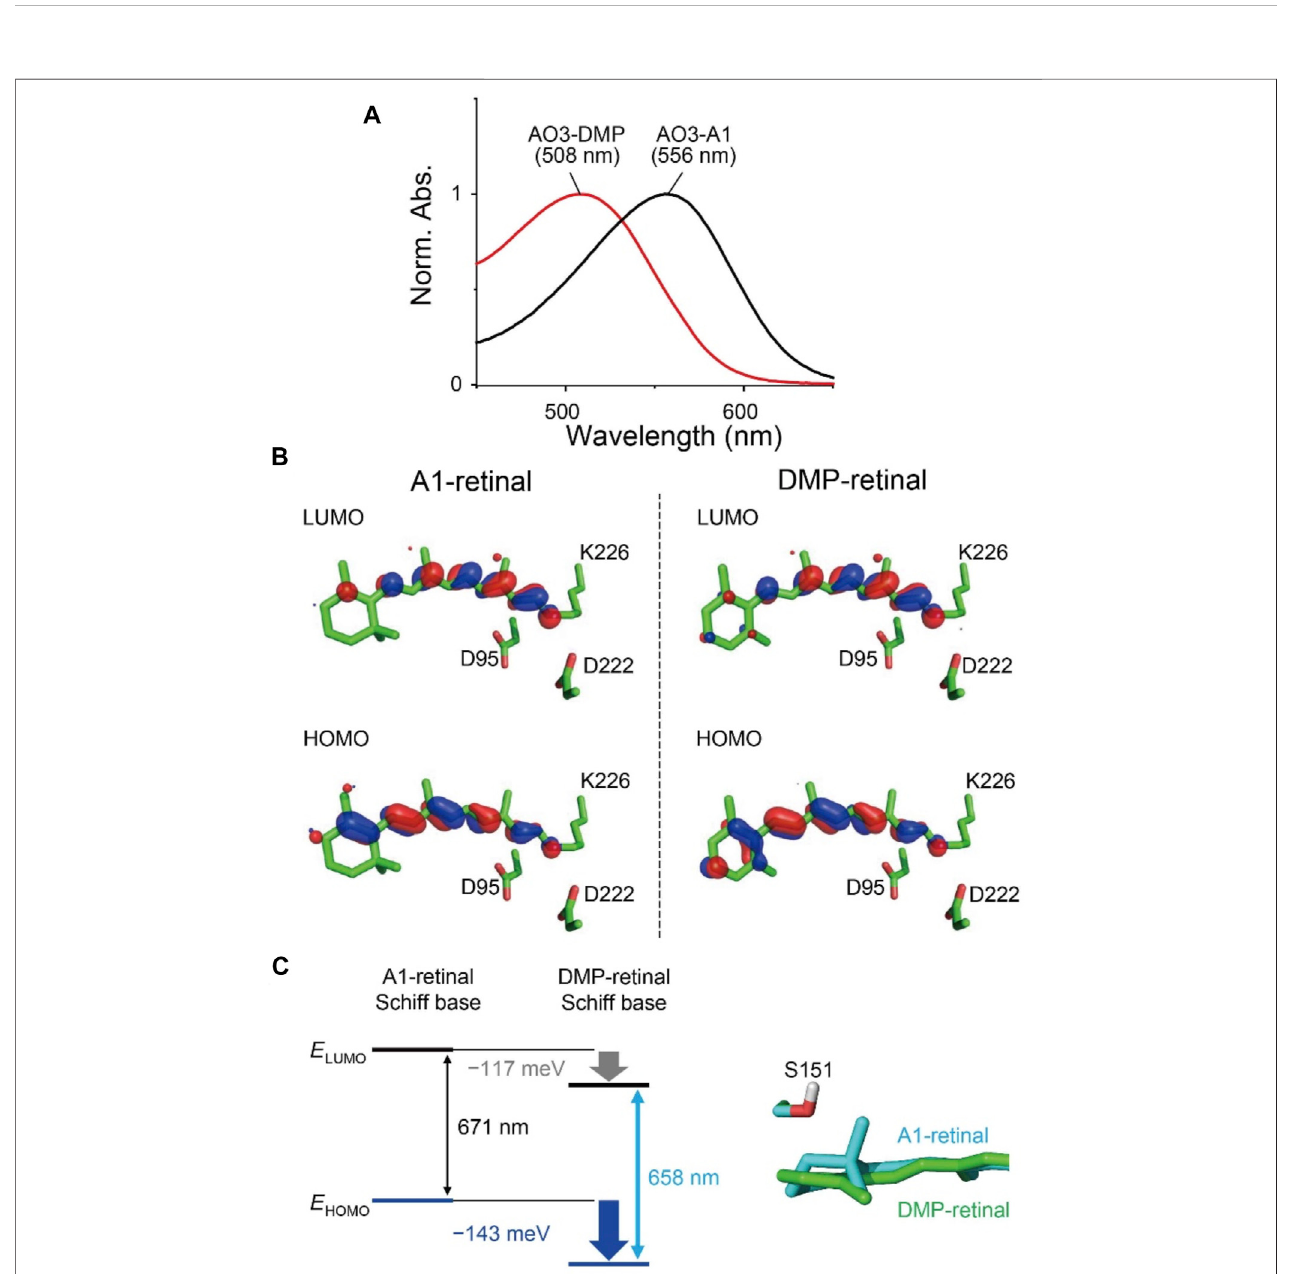
FIGURE 3 | Absorption properties of AO3 with A1-retinal and DMP-retinal. (A) Absorption spectra of puri fi ed AO3 with A1-retinal (AO3-A1, black line) and DMP- retinal(AO3-DMP,redline). (B) HOMOandLUMOforA1-retinal (left) andDMP-retinal (right) SchiffbasesintheAO3proteinenvironments. (C) DifferenceinHOMOand LUMOenergybetweenA1-retinalandDMP-retinalSchiffbasesintheabsenceoftheproteinenvironment(i.e.invacuum) (left) anddifferenceintheplanaritybetweenthe β -ionone ring moiety in AO3-A1 (cyan) and the aromatic ring moiety in AO3-DMP (green) (right) . The data in panel (C) corresponds to the structure in panel B.